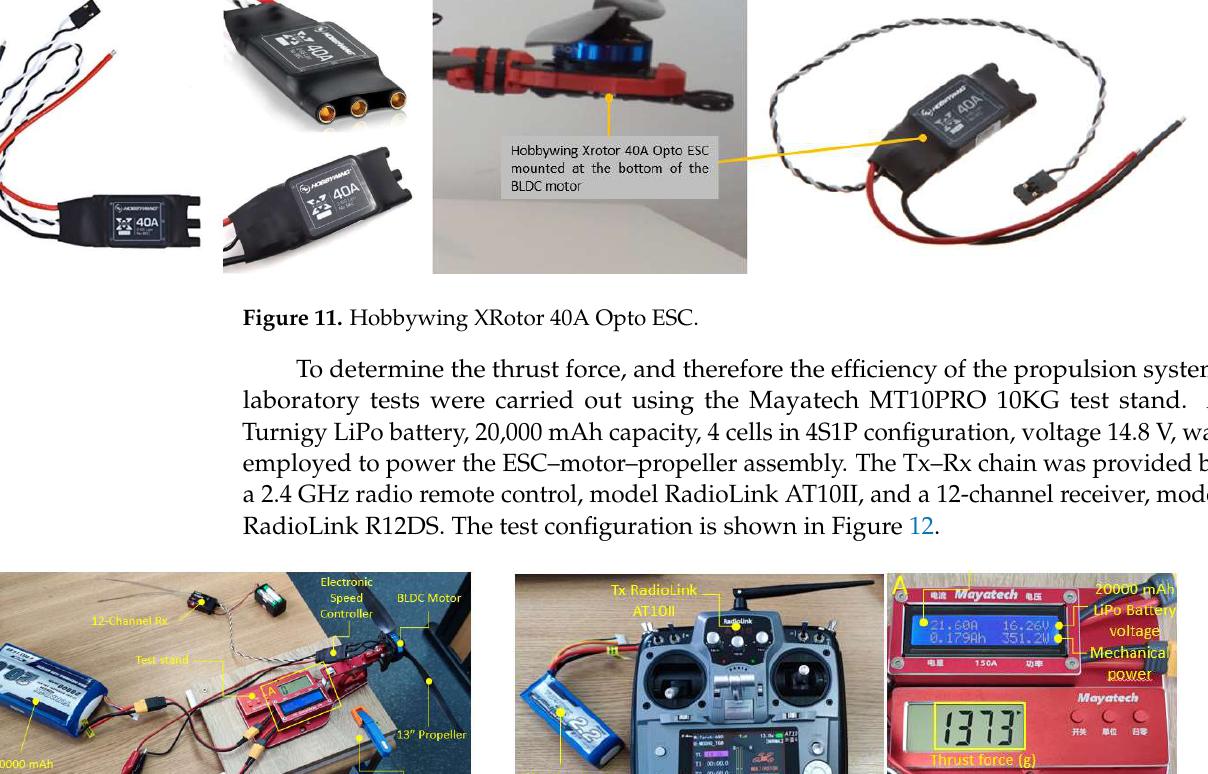
( b ) Figure 10. The ESC architecture and simplified diagram of ESC operation. ( a ) ESC general architecture; ( b ) Simplified diagram of ESC operation. The simplified diagram of ESC, depicted in Figure 10b, employs real-time operation. The main features and parameters of the ESC mounted on the hexacopter are as follows: it is equipped with specially optimized firmware for disc-type motors and a special core program for rapid throttle response, and the refresh rate of the throttle signal supported is up to 621 Hz, making the ESC perfectly compatible with various flight controllers (if